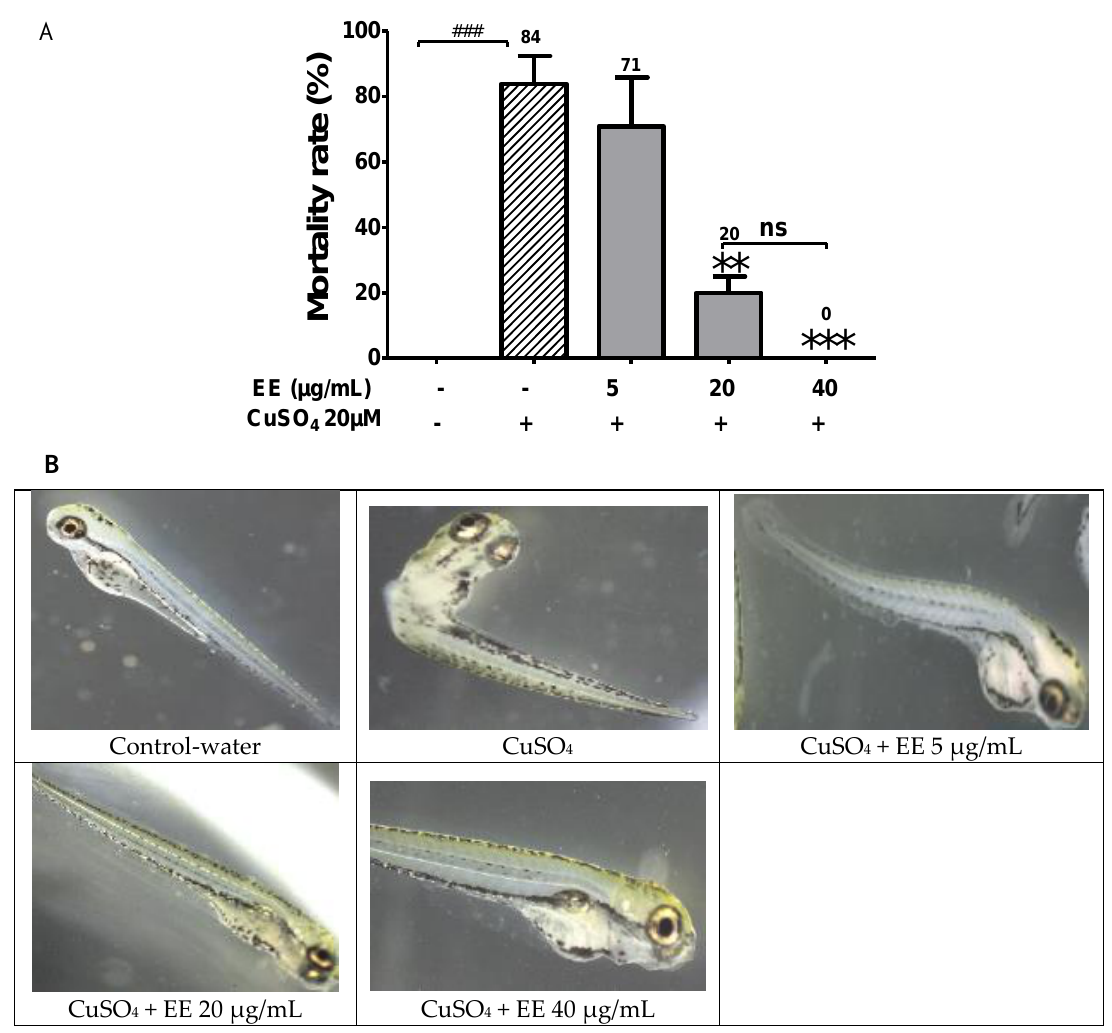
Figure 1. Protective effect of the ethanol extract of C. cyrtophyllum leaves (EE) against CuSO 4 toxicity. (A) Mortality rates of zebrafish larvae after treatment with 20 µM CuSO 4 and ethanol extracts of C. cyrtophyllum (EE) at different doses. (B) Representative photographs of zebrafish larvae treated with 20 µM CuSO 4 and ethanol extracts of C. cyrtophyllum (EE) at different doses. The data are presented as mean ± S.E. for three different experiments performed in triplicate. ### p < 0.001, ** p < 0.01, and *** p < 0.001 compared to the CuSO 4 alone group.